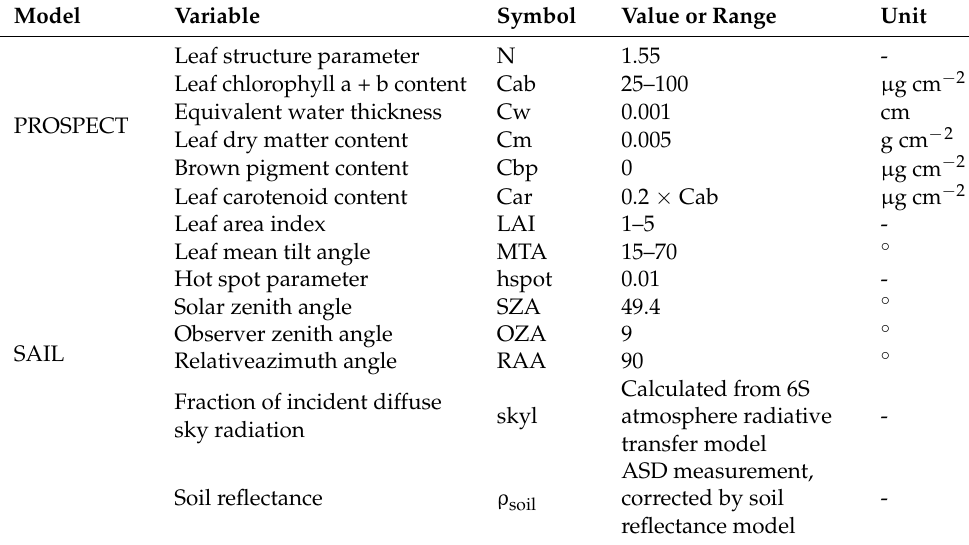
Table 1. The variable settings of the PROSAIL